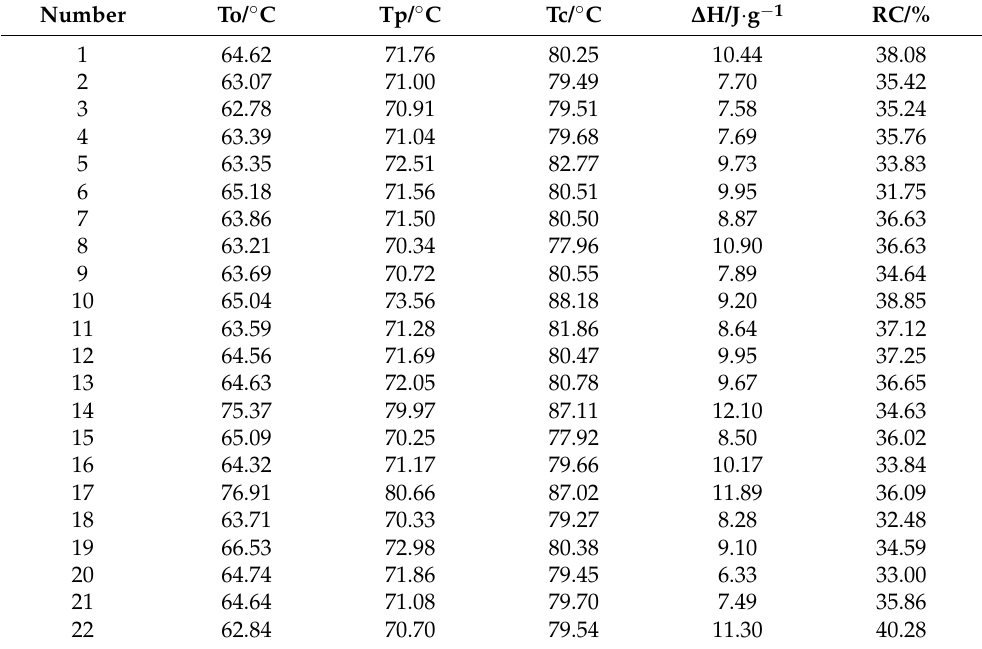
Table 4. The thermodynamic characteristic values of the 29 glutinous rice